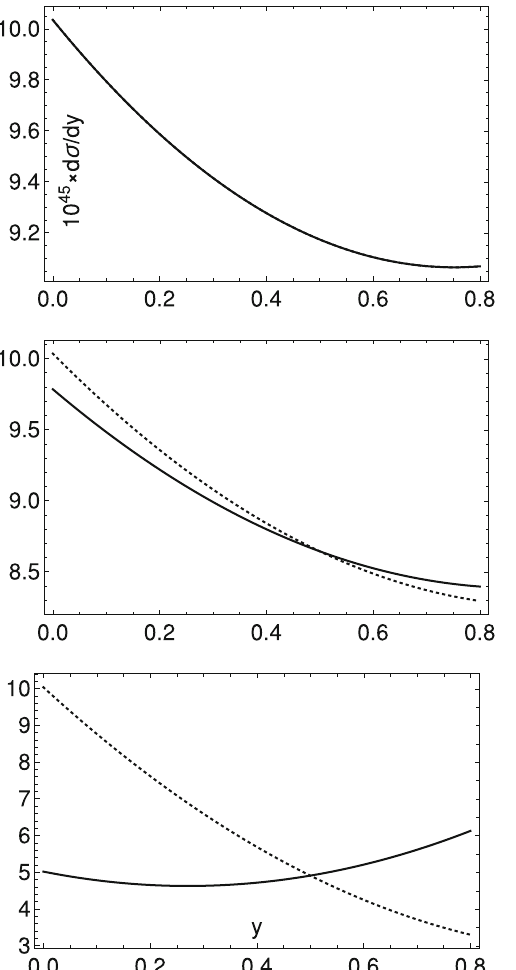
= S Fig. 10 Superposition of LC ν e s with RC ones in presence of non- standard couplings with ˆ η ν · ˆ q = − 0 . 95: dependence of d σ/ d y on y for different values of θ 1 when E ν = 1 MeV , φ ν = 0. Upper plot for θ = 0; middle plot for θ 1 for Dirac ν e with V – A and T R , | c R Majorana ν e with V – A with S R , | c R Dirac ν e with V – A and S R when | c R